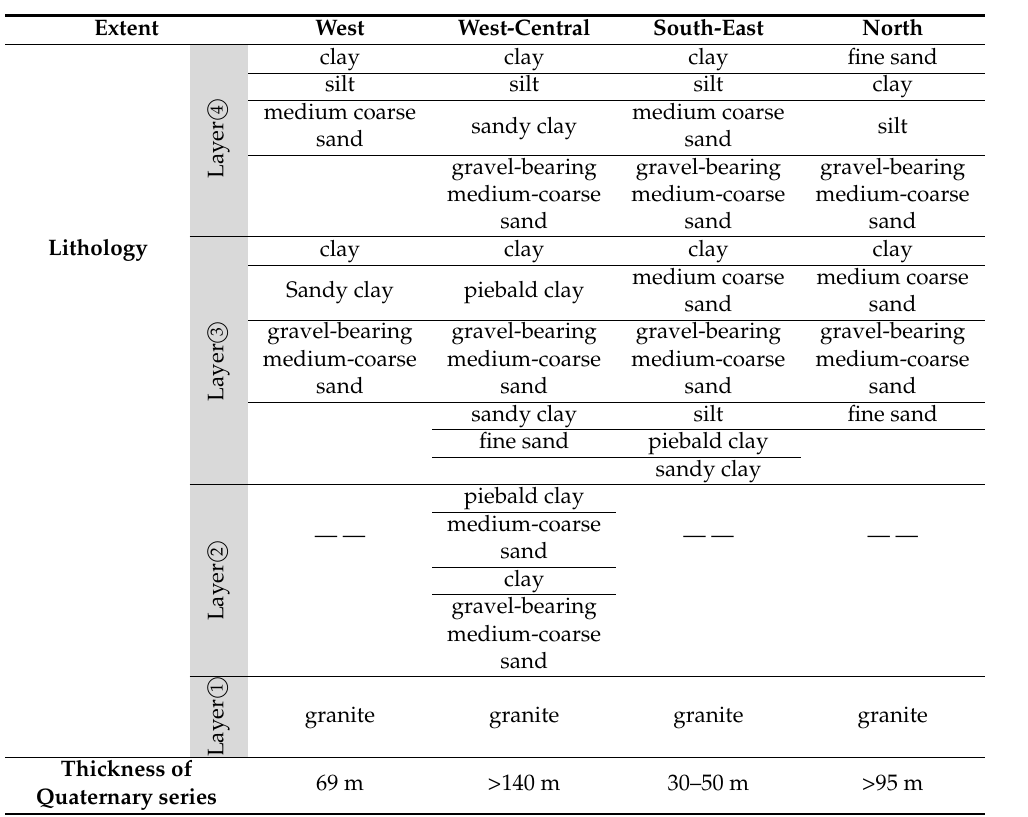
Table 4. Quaternary series distribution in LJP. Layers 2 (cid:13) – 4 (cid:13) are Quaternary units, and the thickness